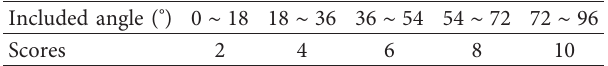
Table 8: The scores of included angles between gateway axis and major horizontal principal stress.